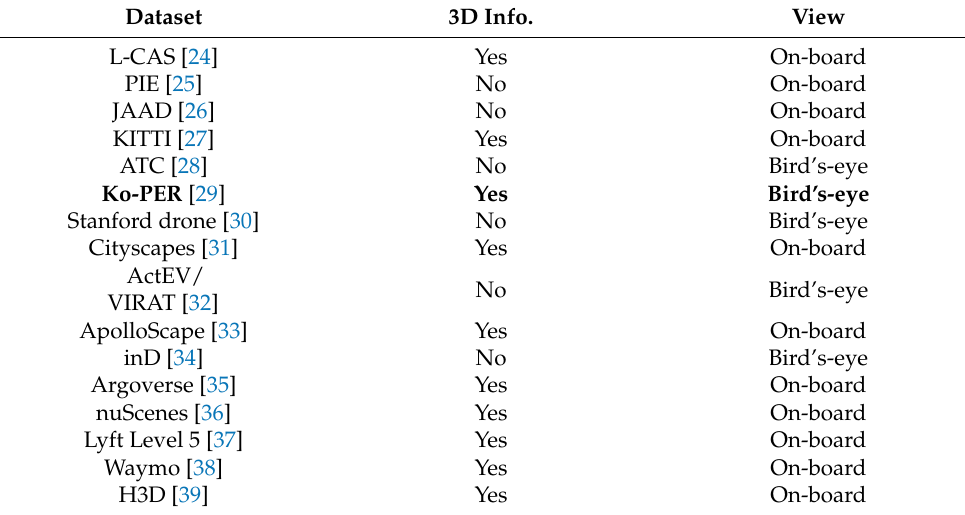
Table 2. Pedestrian intention prediction